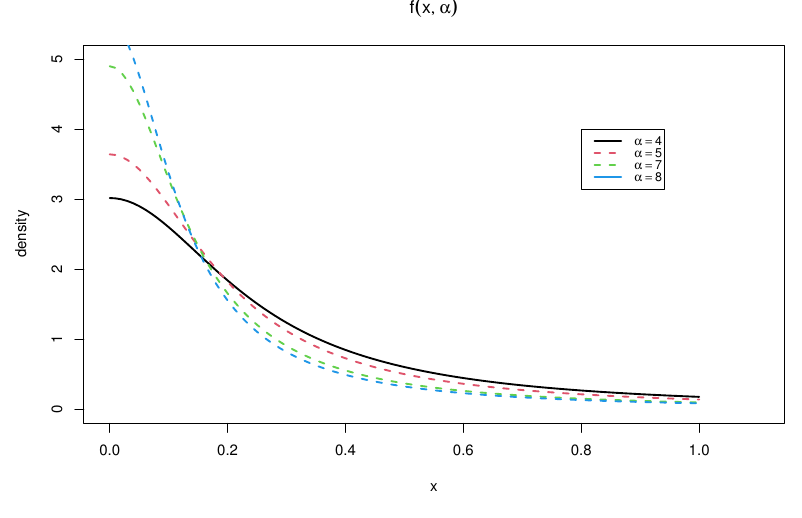
Figure 1. Plots of the pdf in